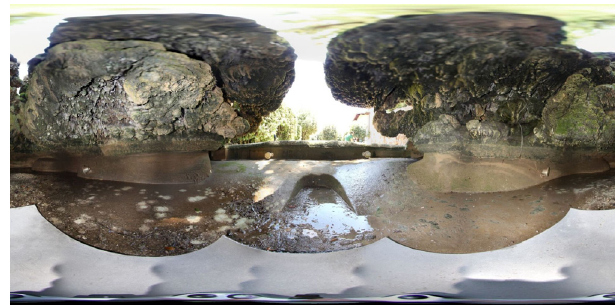
Figure 6. Equirectangular image with external camera on Nodal Ninja 3 panoramic head.